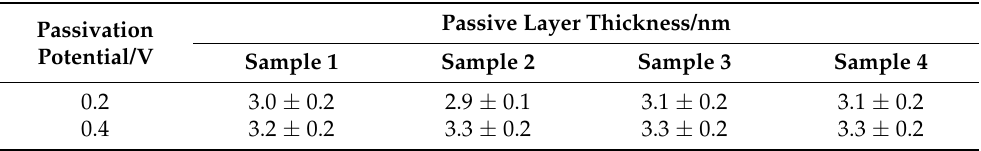
Table 3. Passive layer thickness values of all samples acquired from XPS data.